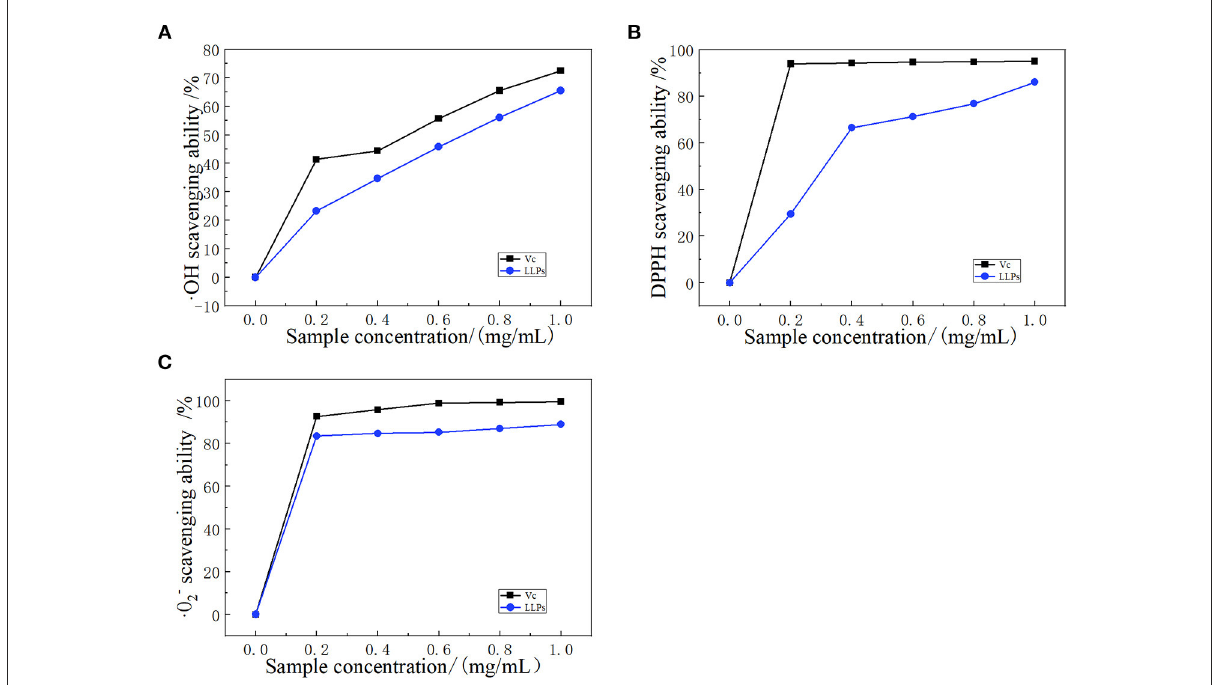
FIGURE6 Scavenging effect of LLPs on (A) · OH radicals compared with V C , (B) DPPH radicals compared with V C, and (C) · O − 2 radicals compared with V C